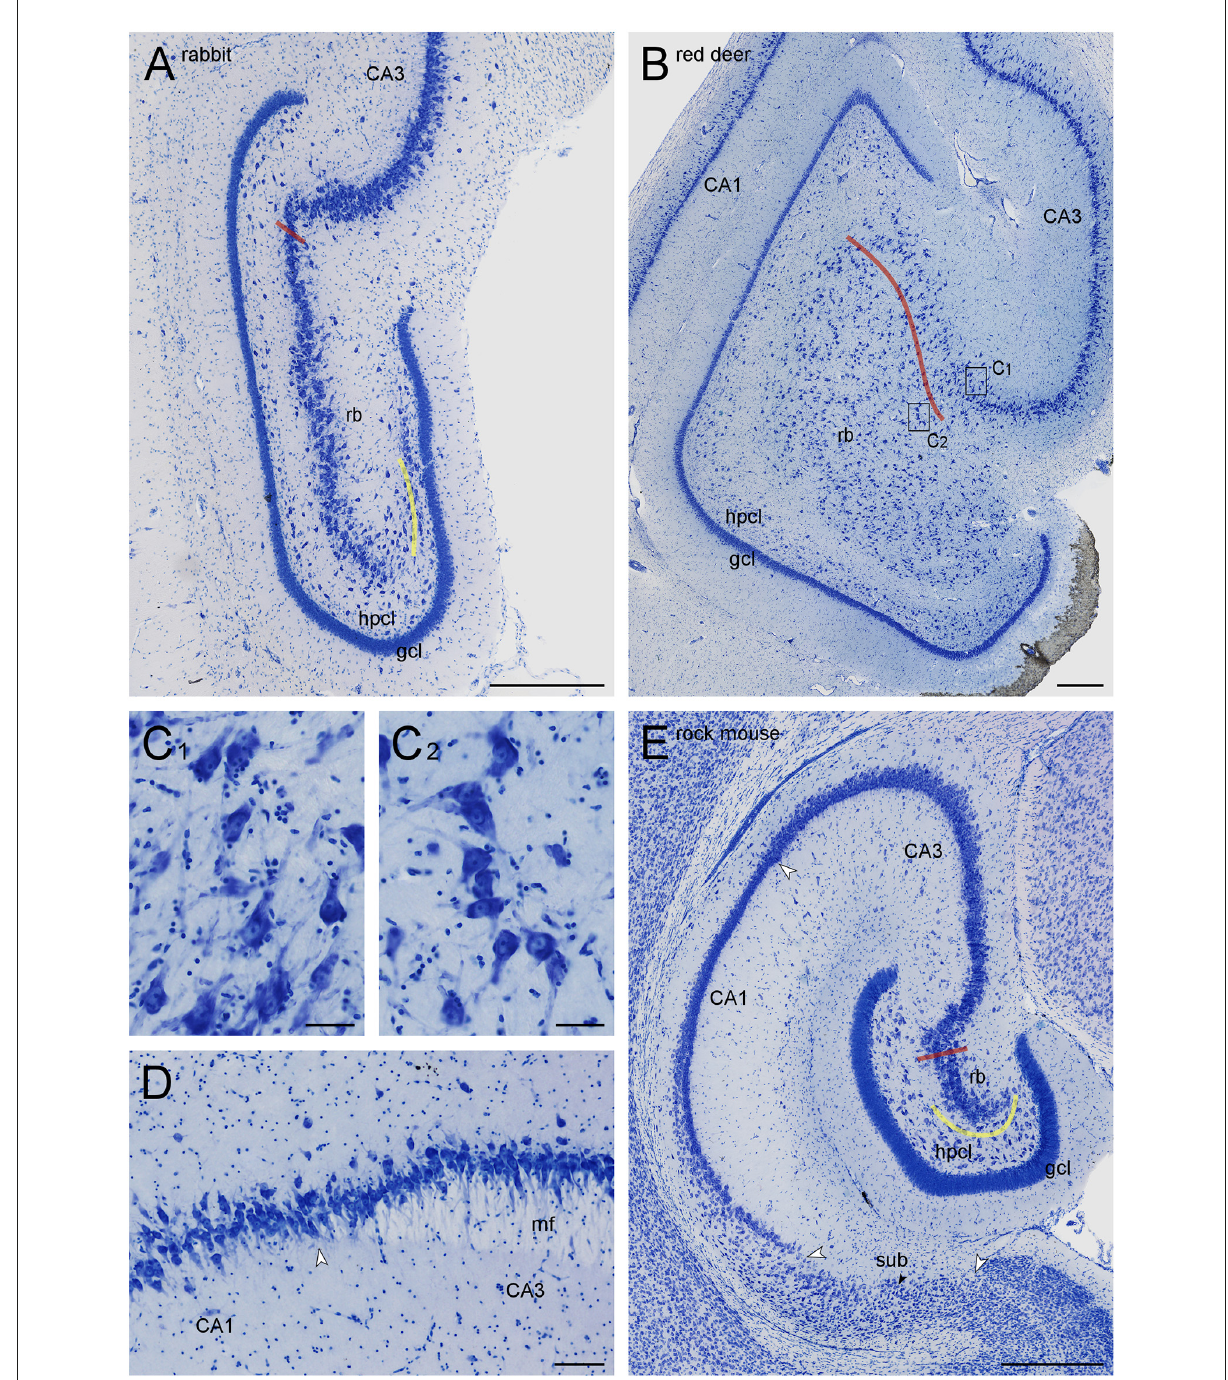
FIGURE1 Dentate gyri of the New Zealand white rabbit (A) and the red deer (B,C) , distal tip of the mossy fiber zone in boar (D) , and hippocampal formation of the Namaqua rock mouse (E) . Red lines mark the border of the CA3 reflected blade (rb) towards the remainder of CA3. Yellow lines mark the boundary between the reflected blade and the hilar polymorphic cell layer (hpcl) in species in which they partially merge. Rectangles in (B) labeled (C1,C2) mark the positions of the high magnification images (C1,C2) . Large white arrowheads in (D) mark subregional boundaries. The small black arrow in (E) marks the tentative boundary between the proximal subiculum (or prosubiculum) and the distal subiculum. The apical dendrites of CA3 pyramidal cells consistently point towards the superficial layers of CA3 (C1) , whereas the apical dendrites of CA3 reflected blade pyramids (C2) point towards the granule cell layer, even though the hippocampal layers would be much closer. At the transition from CA3 to CA1 (D) , a background staining of the mossy fiber zone (mf) is lighter than that of the adjacent stratum radiatum, clearly marking the border of CA3 in most sections of all species. Scale bars: (A,B, and D) 0.5 mm; (C1) and (C2) 50 µ m; (C3) 100 µ